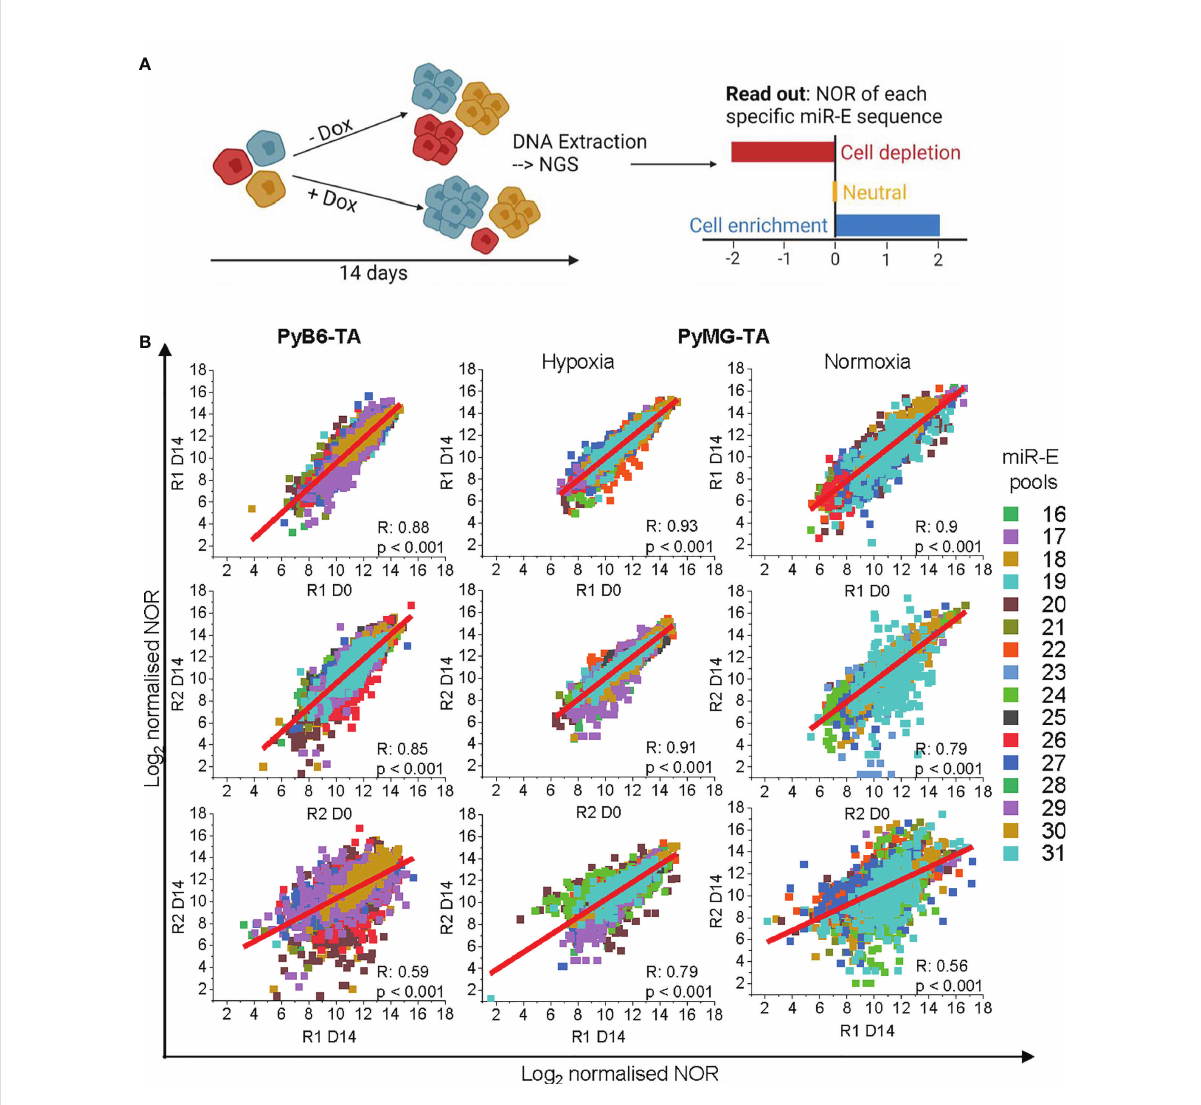
FIGURE 2 Competitive growth screen. (A) Schematic representation of the competitive growth screen setup. Cells carrying different miR-E constructs in different colors. NGS, next-generation sequencing; NOR, number of miR-E reads. (B) Correlation plots of Log 2 -transformed normalized sequencing reads of Replicate 1 (R1) and Replicate 2 (R2) compared between day 14 and day 0 within the replicated and day 14 between the replicates. miR-Es corresponding to speci fi c pools in color code. For technical reasons, the 16 miR-E pools were termed pools 16 – 31. R, Pearson R correlation coef fi cient; p, Pearson R corresponding signi fi cance. OriginPro function: linear fi